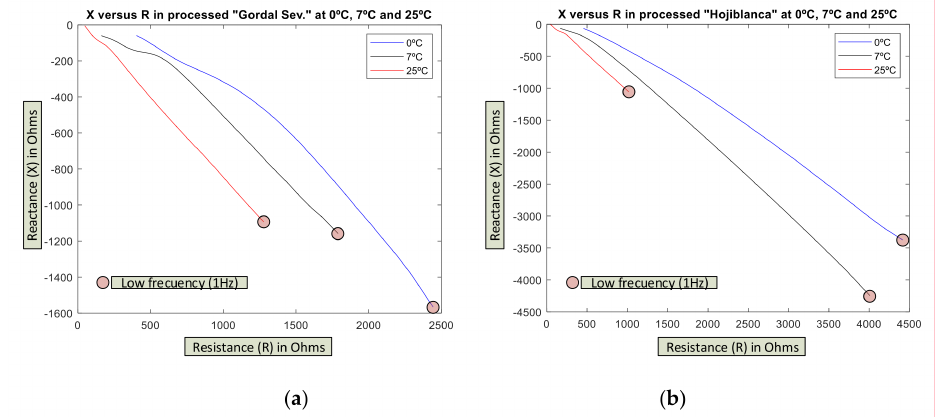
Figure 7. The e ff ect of temperature on electric impedance on the ( a ) “Gordal Sevillana” and ( b ) “Hojiblanca” olive varieties processed in the “Estilo Sevillano” way in at 3 temperatures: 0 ◦ C, 7 ◦ C, and 25 ◦ C (average values of 100 tests).